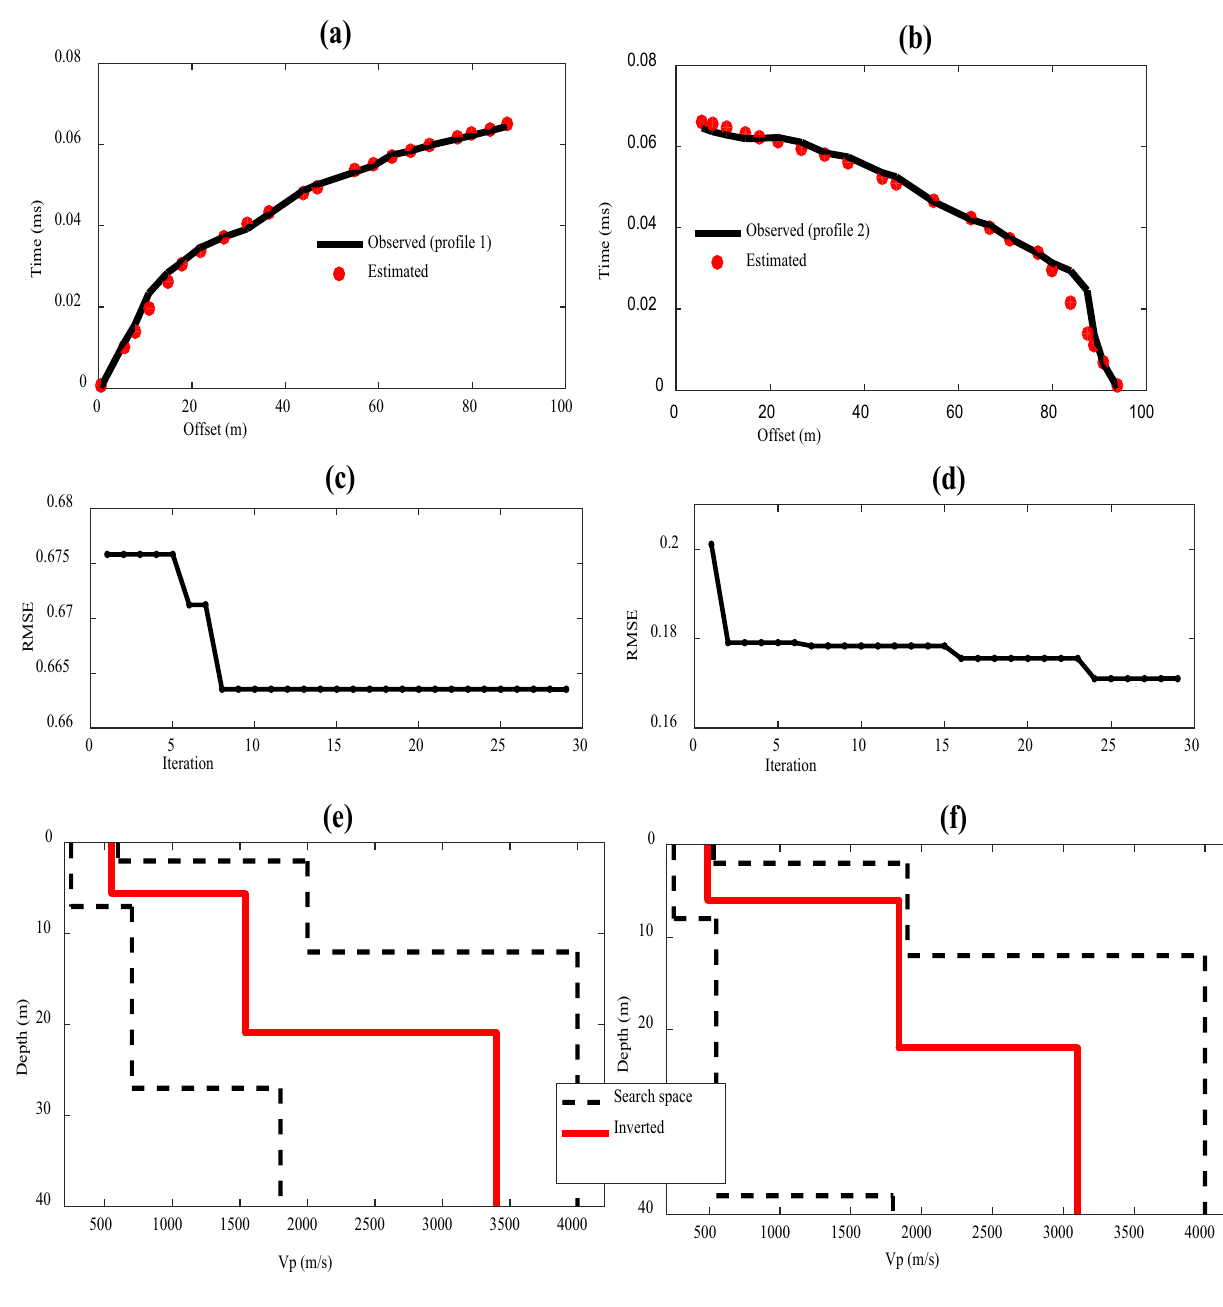
the RMSE over the inversion of profiles 1 and 2, respectively, e , f the modeled Vp profiles related to observed travel times, i.e., profiles 1 and 2,